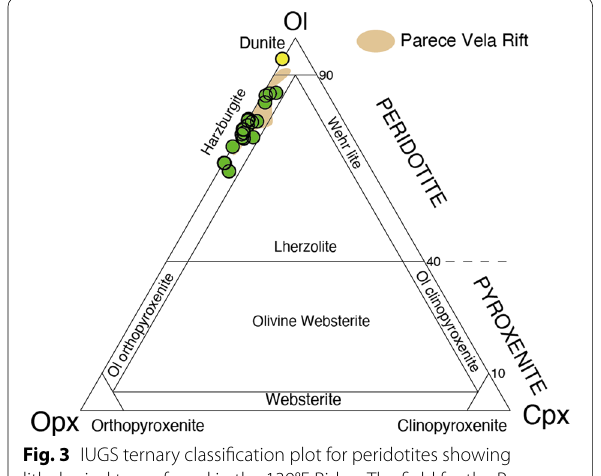
Fig. 3 IUGS ternary classification plot for peridotites showing lithological types found in the 139°E Ridge. The field for the Parece Vela Basin is shown by orange domain after Ohara et al. (2003)